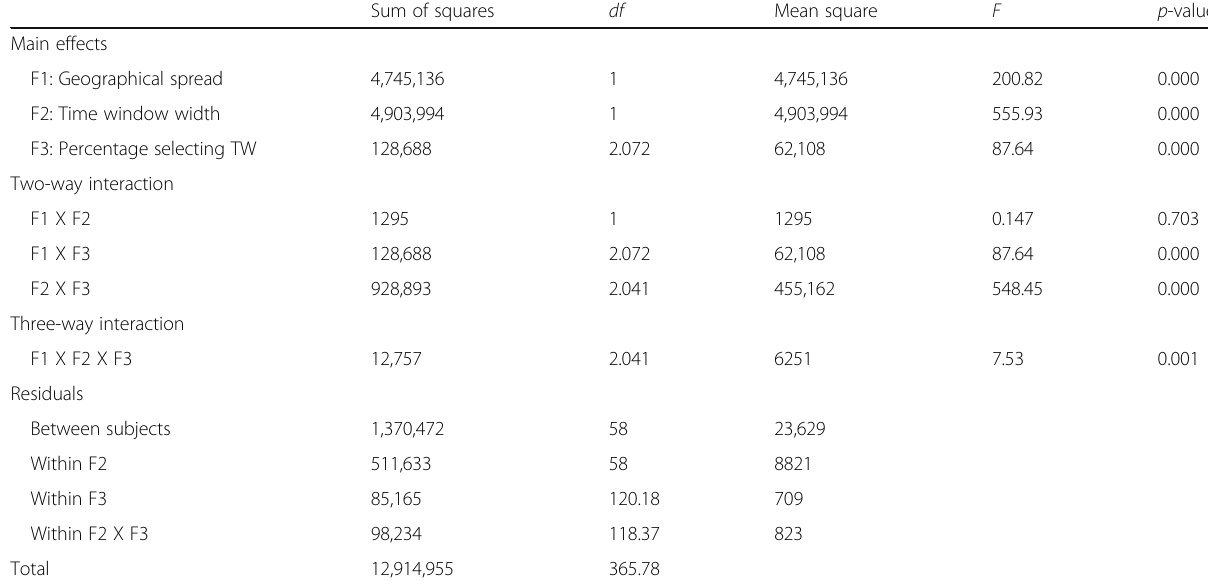
Table 3 Mixed model ANOVA results (design 1) Sum of squares df Mean square